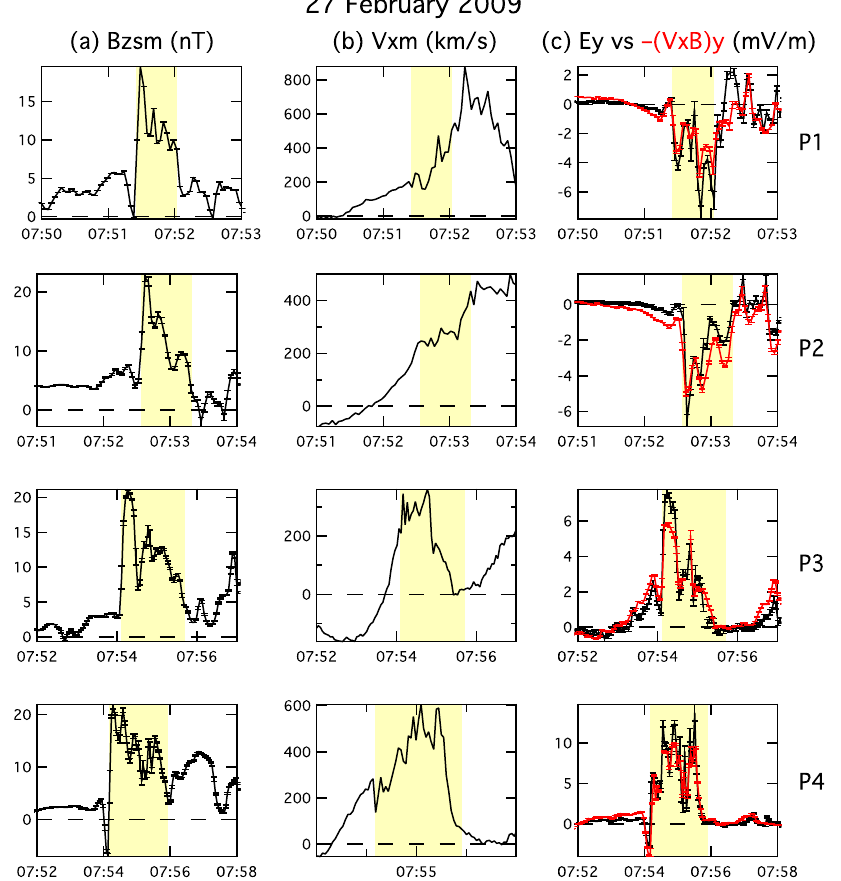
Figure 2. The B z component, plasma bulk flow Uxm, and comparison between E y and − ( U × B ) y for four THEMIS (Time History of Events and Macroscale Interactions during Substorms) satellites on 27 February 2009. The two quantities in evaluating the FIC agree reasonably well. The DFB interval is highlighted in the figure. Prior to the arrival of DFB, the B z com- ponent was quite small. A magnetic dip for ~1–2 min appeared at the front of the DFB ahead of sharp enhancement of the B z component. Two of the dips had negative values. Earthward flows increased significantly in DFB. The comparison between the two frozen- in parameters shows generally good agreement; therefore, magnetic flux can be consid- ered to be transported by plasma flow in this event.